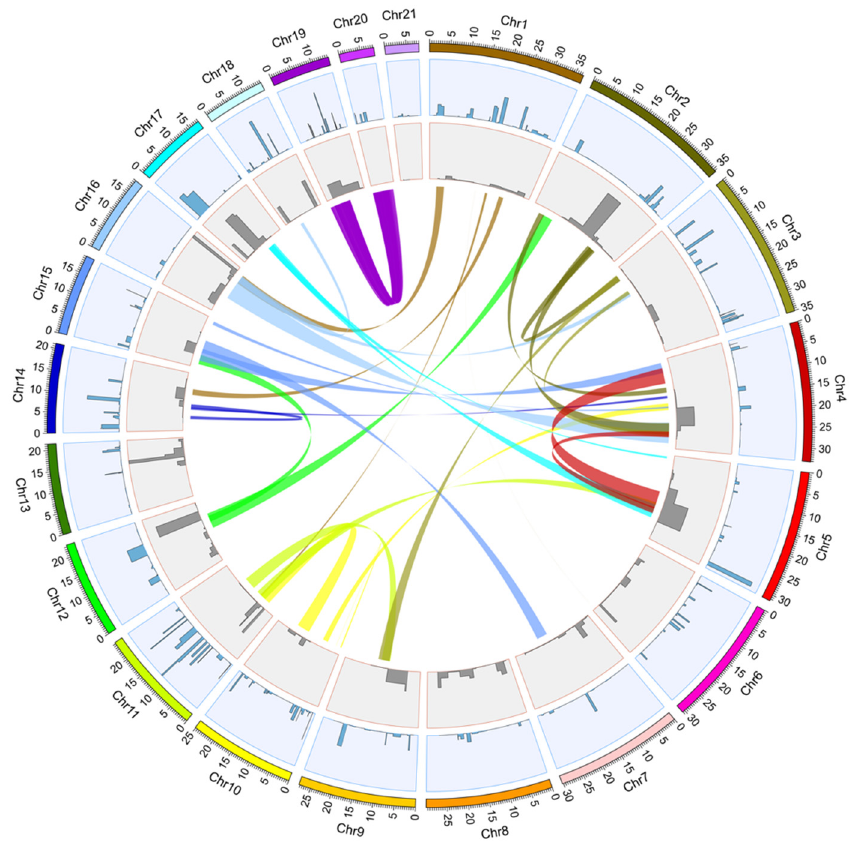
Figure 1. Identification of trypsin and bantam genes in the C. rogercresseyi genome through CIRCOS plot. Chr1–Chr21 colored segments correspond to the complete sequence of the chromosomes of the sea louse genome using a chromosome unit value of 100,000 bp. The first track (light blue) corresponds to a histogram plot of reads mapped in genes annotated as trypsin, trypsin-like, and chymotrypsins for this species. The second track (gray) shows the read mapping for annotated bantam miRNAs in the sea louse genome. Links correspond to syntenic blocks in the C. rogercresseyi genome obtained from blastN analyses of 10,000 bp segments throughout the whole genome.